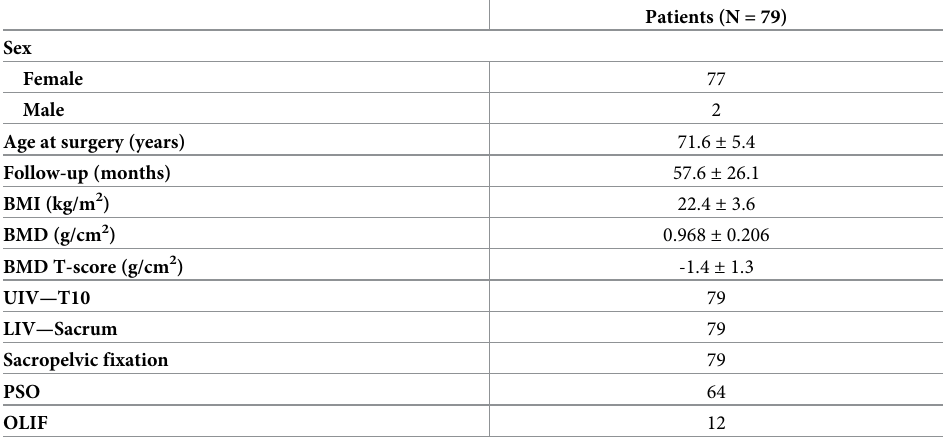
Table 1. Baseline